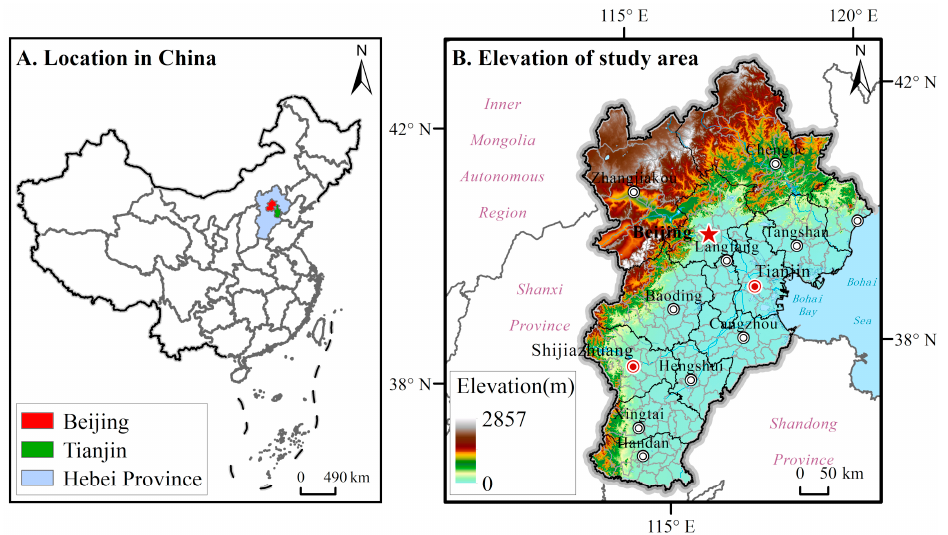
Figure 1. Study area: ( A ) the location of the Beijing–Tianjin–Hebei urban agglomeration in China; ( B ) the administrative division and elevation of the Beijing–Tianjin–Hebei urban agglomeration.